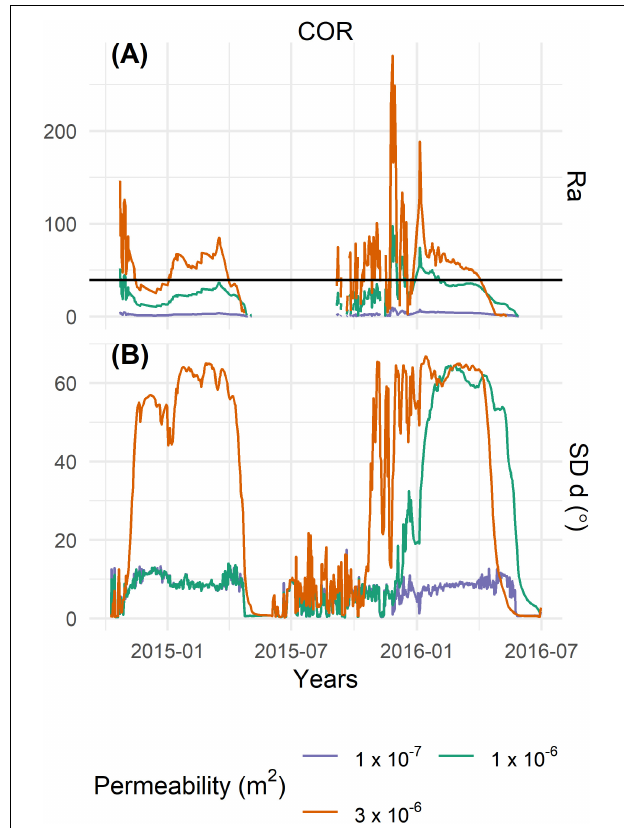
FIGURE 8 | Excerpt of Figure 7 from beginning of October 2014 until end of June 2016 to show the interaction of Ra (A) and the onset, respectively the duration of convection, characterized by the standard deviation of d (B) , plotted on daily values, over a shorter time period. Different permeability values are represented by different colors, data is from COR rock